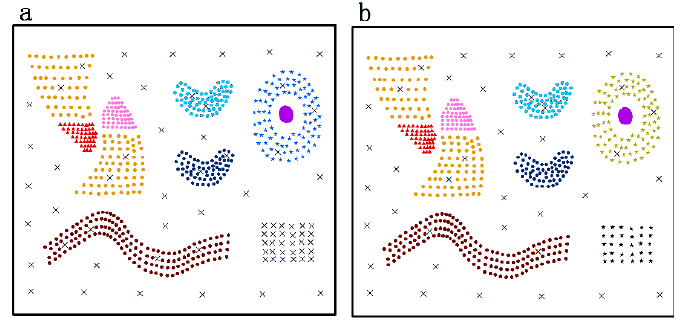
Figure 9. Construction of spatial proximity relationships of 𝑆2 : ( a ) Delaunay triangulation of 𝑆2 ; and ( b ) Modified Delaunay triangulation of 𝑆2 .